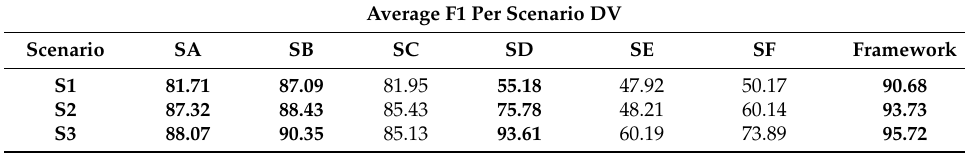
Table 16. Average F1 per scenario